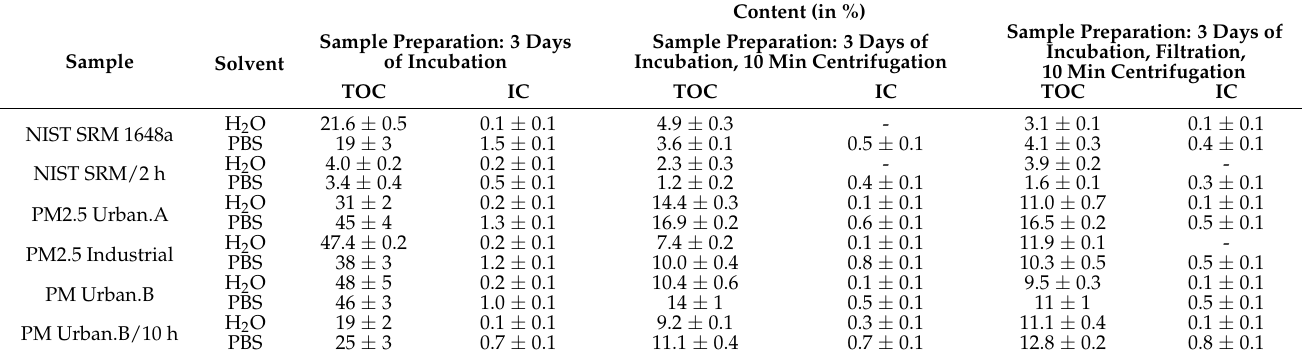
Table 1. Inorganic carbon (IC) and total organic carbon (TOC) content of prepared extracts.